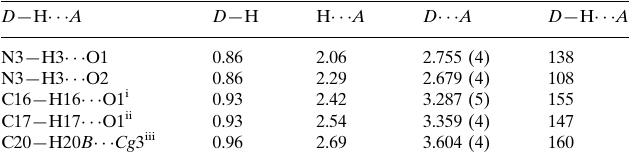
Data collection Bruker APEXII CCD area-detector diffractometer Absorption correction: multi-scan ( SADABS ; Sheldrick, 1996) T min = 0.947, T max = 0.960